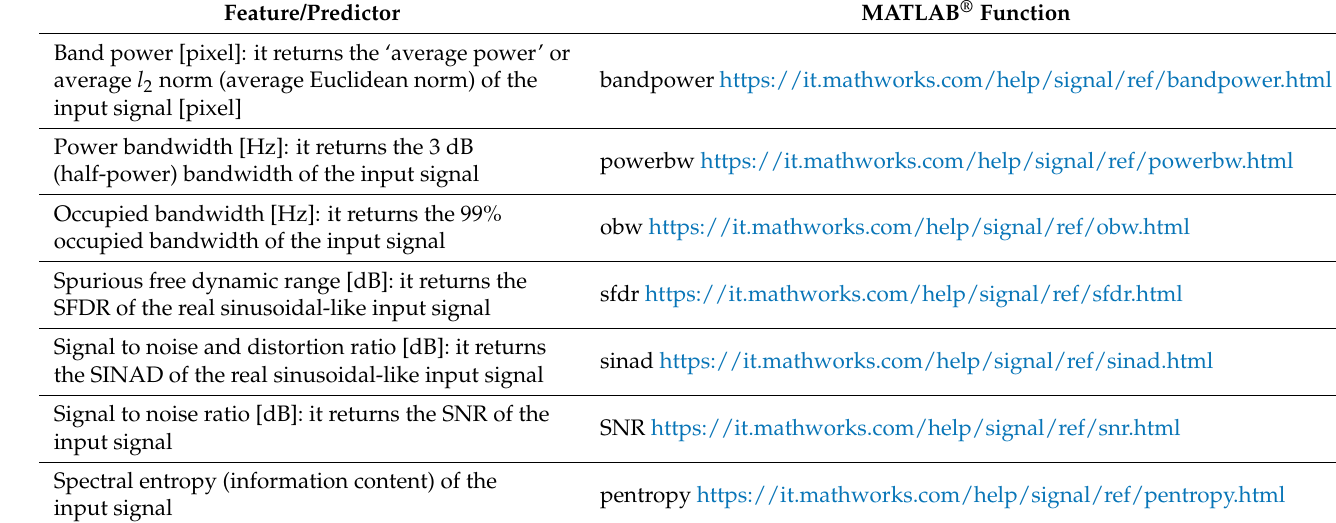
Table 1. Set of features/predictors extracted from the periodic movement of the RV. A total of 7 features/predictors are calculated for both x and y coordinates. A citation for each feature is shown in the table (each link was accessed on 1 August 2021). Feature/Predictor MATLAB ®